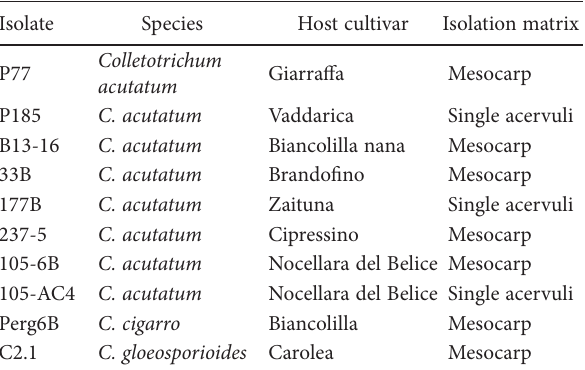
Table 1. Strains of Colletotrichum from different Sicilian olive culti- vars used in the present